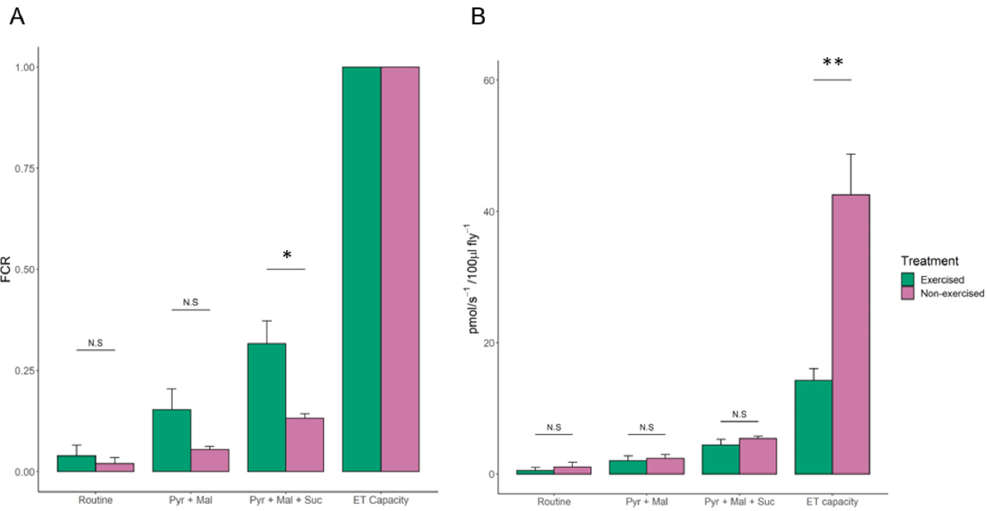
Figure 4. ( A ) Flux control ratio (FCR), in exercised and non-exercised male D. melanogaster ; and ( B ) specific flux oxygen consumption in exercised and non-exercised male D. melanogaster ( n = 3). Significant p -values: ( A ) succinate p -value = 0.025; ( B ) ET capacity p -value = 0.002. N.S = >0.05, * = <0.05, ** = < 0.01. Table 1. Mean values of the specific flux and flux control ratio in exercised and non-exercised male